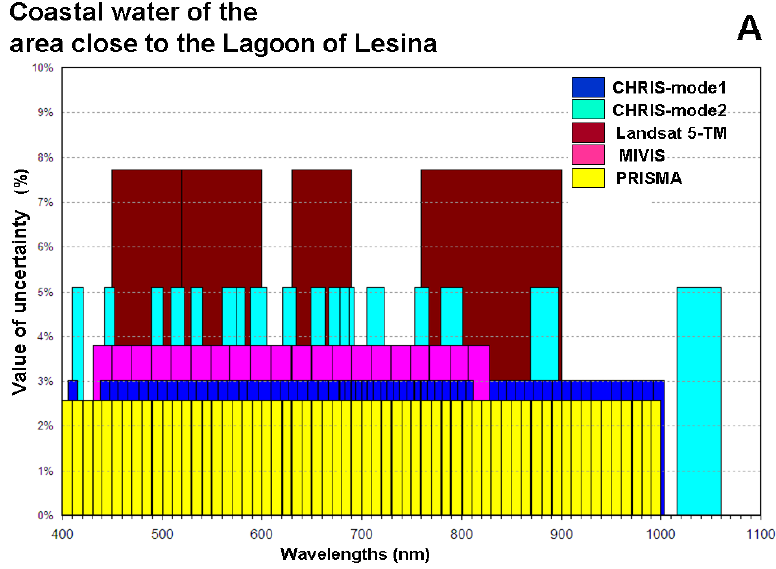
Figure 3. The values of the uncertainty with respect to the spectral characteristics of the data: ( A ) the values of the uncertainty with which these data characterize the coastal waters of the area close to the Lagoon of Lesina; ( B ) the values of the uncertainty, with which these data characterize the coastal waters of the Gulf of Manfredonia; ( C ) the values of the uncertainty, with which these data characterize the coastal waters of the Gulf of